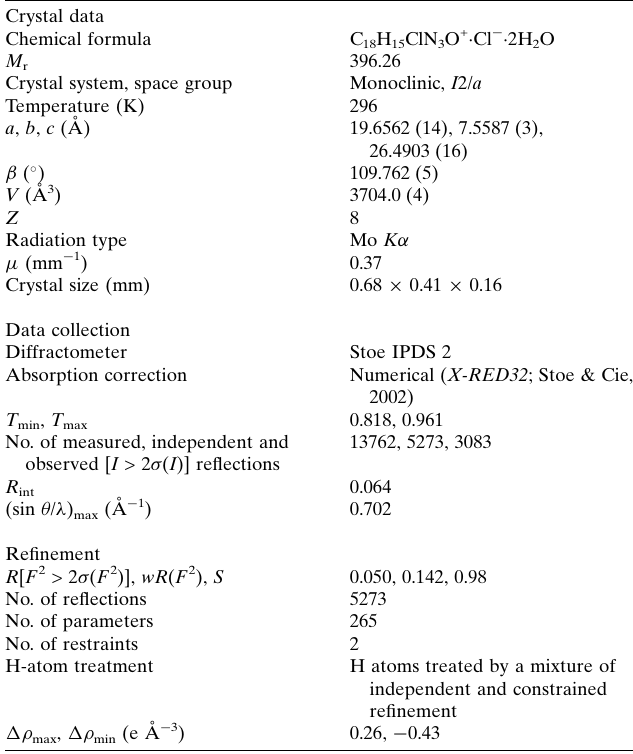
Table 2 Experimental details. Crystal data Chemical